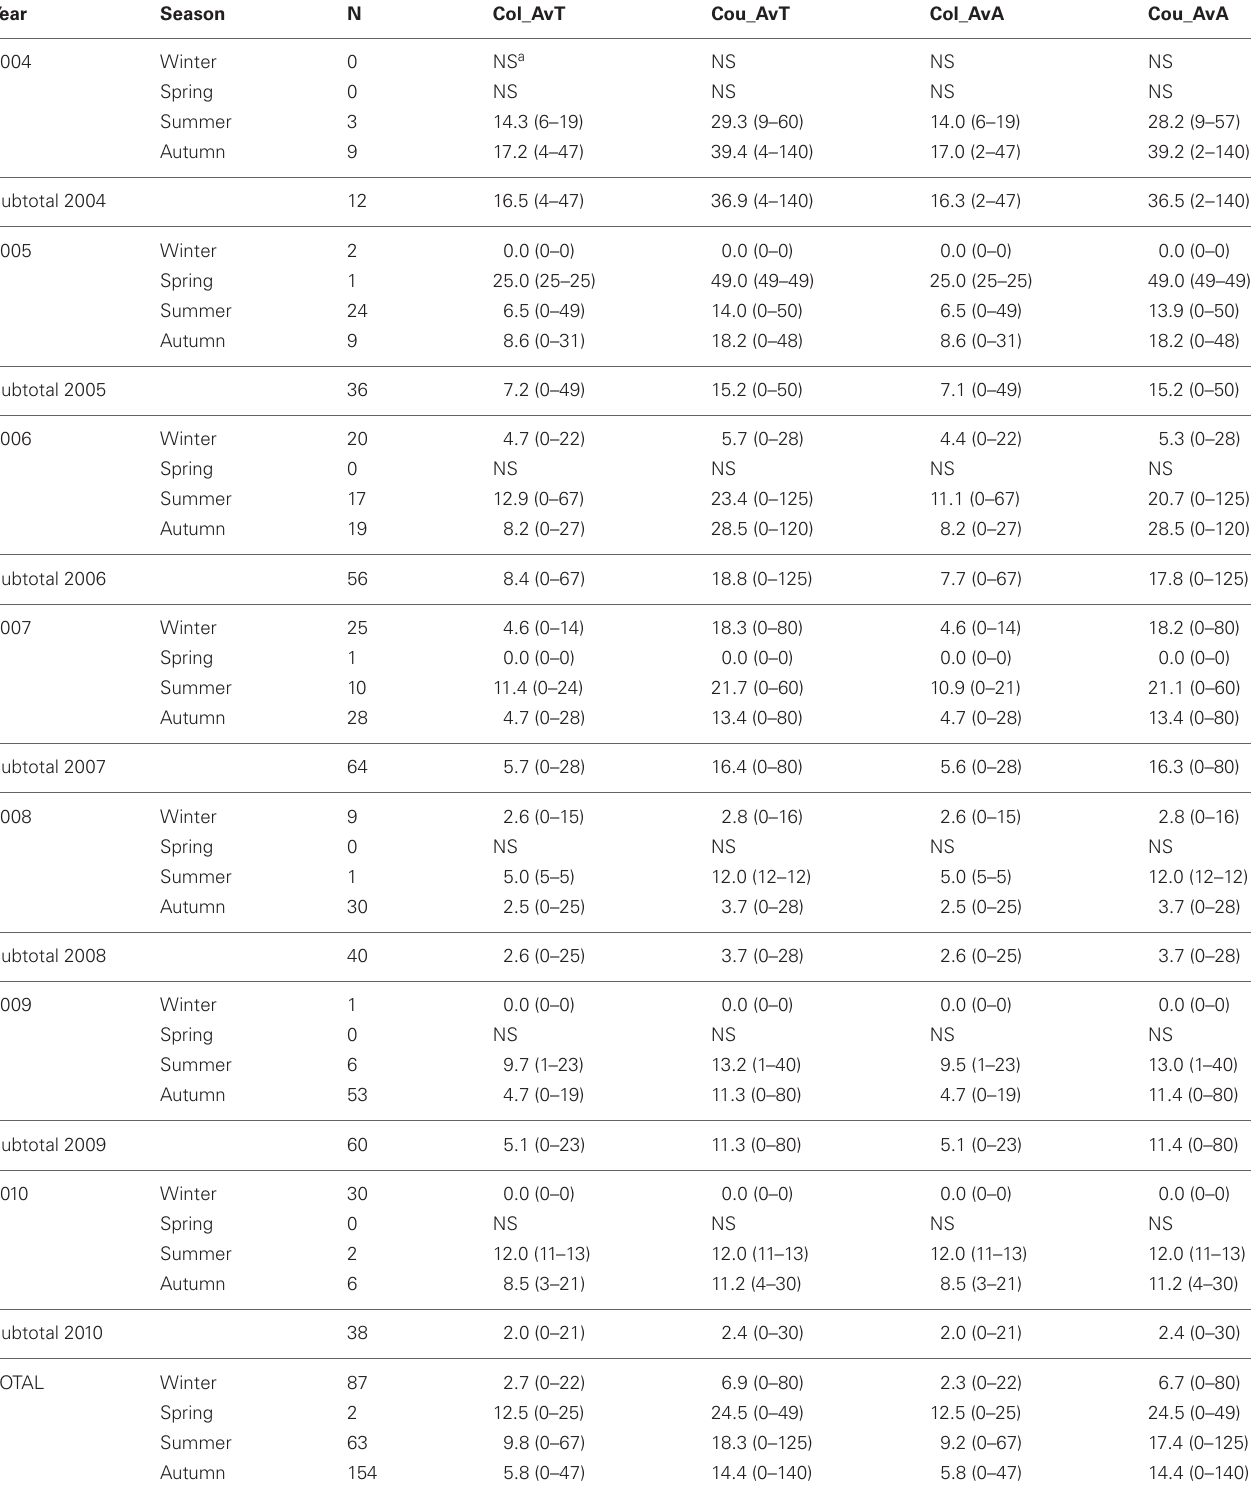
Table 4 | Average number of ticks/deer collected (Col_AvT) and counted (Cou_AvT) and average number of adult ticks/deer collected (Col_AvA) and counted (Cou_AvA) throughout year and